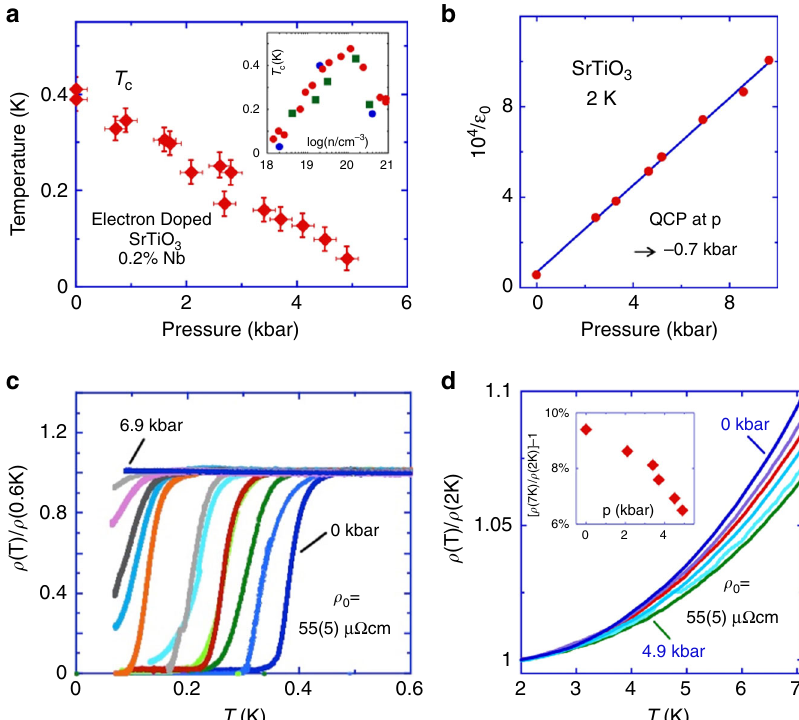
Fig. 2 The observed superconductivity temperature – pressure phase diagram for Nb-doped SrTiO 3 . a Superconducting transition temperature, T c , as determined from resistivity data vs. pressure for a SrTi 1- x Nb x O 3 sample (see “ Methods ” section) with a carrier density depending on x near the dome maximum of T c vs. n shown in the inset (red circles are from S27, green squares are from S23 and blue circles are our data, Fig. S1). b Pressure dependence at low T of the inverse dielectric constant 1/ ε 0 , proportional to Ω (0) 2 , for the undoped state 4,6,S16,S17 . Ω (0) is only slightly changed (see Eq. (10)) up to carrier concentrations of around 10 19 cm − 3 S34 . c T dependence of the resistivity, ρ , below 1 K at different pressures in the same sample as in a . ρ is scaled to the normal state residual value, ρ 0 , which is weakly dependent on pressure. T c in a is de fi ned from the 10% drop of ρ from ρ 0 . For decreasing values of T c , p = 0, 0 (after decompression), 0.9, 1.6 1.7, 2.6, 2.8, 3.4, 3.7, 4.1, 4.5, 4.9, 6.9 kbar, respectively. d T dependence of ρ above 1 K at different pressures scaled to ρ 0 . The pressures may be inferred from the inset, which shows the relative change of the T 2 resistivity coef fi cient (see caption of Fig. S1) vs. pressure. The collapse of T c with increasing pressure and hence 1/ ε 0 is seen to be extraordinarily rapid, pointing to a signi fi cant growth of the pairing strength on approaching the ferroelectric quantum critical